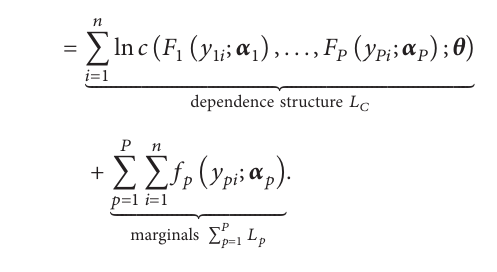
Figure 2: Overview of the motor vibration-based ADT